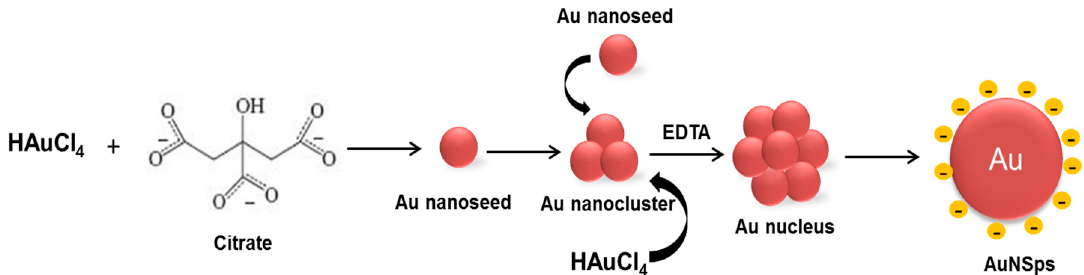
Figure 2. Fabrication process of gold nanospheres (AuNSps).